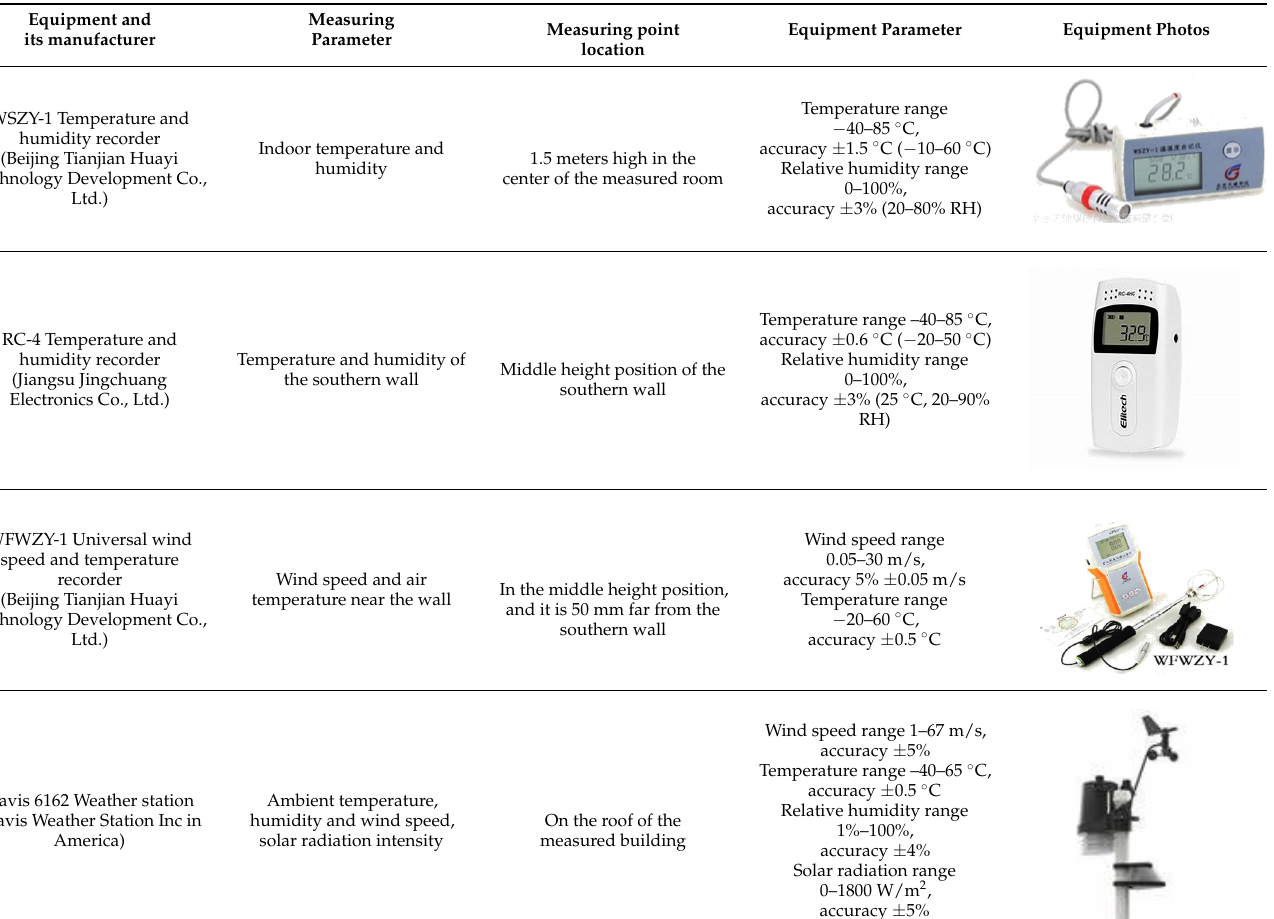
Table 3. Introduction of measuring equipment and parameters.